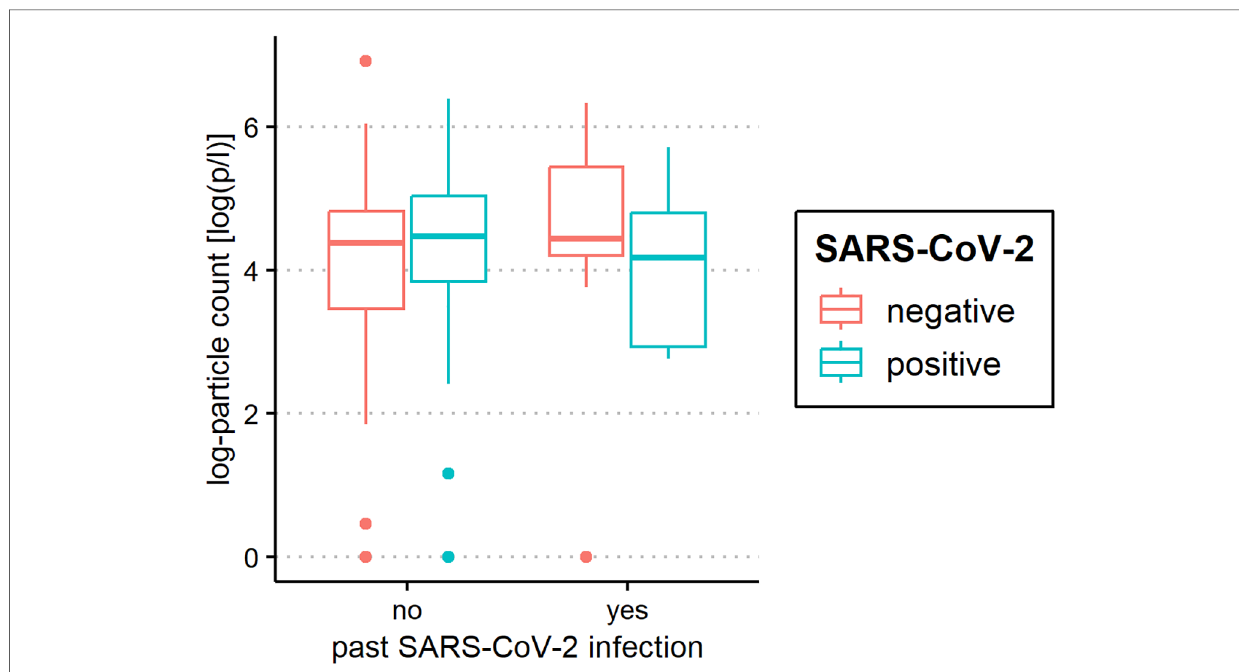
FIGURE 5 Aerosol measurement in relation to past severe acute respiratory syndrome coronavirus 2 (SARS-CoV-2) infection. Exhaled particle counts (in particles/ liter, displayed on a logarithmic scale, y -axis) in SARS-CoV-2 polymerase chain reaction (PCR) -positive and PCR-negative children and adolescents displaying the relation to past coronavirus disease 2019 (COVID-19) infection ( x -axis).